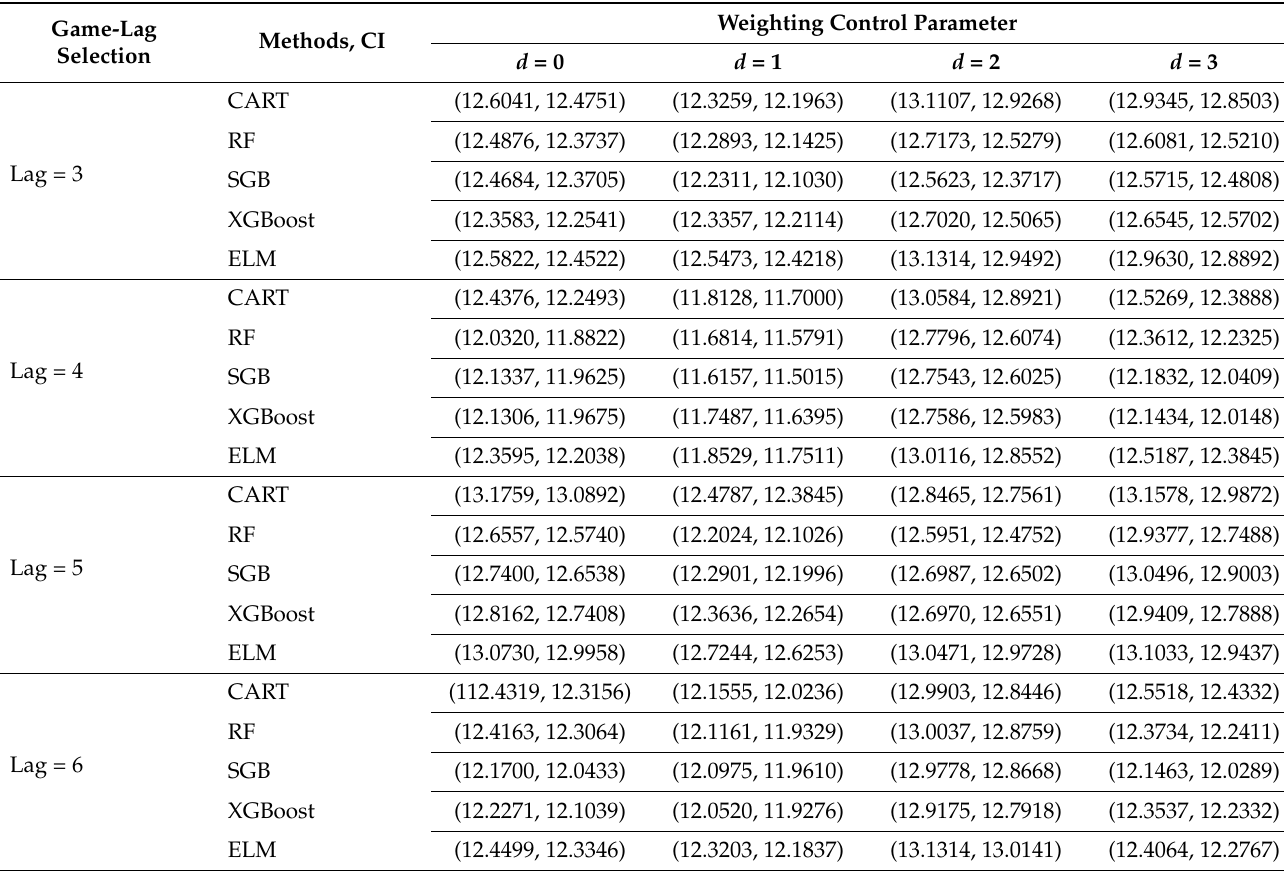
Table 3. Confident intervals of performance metrics of the proposed prediction